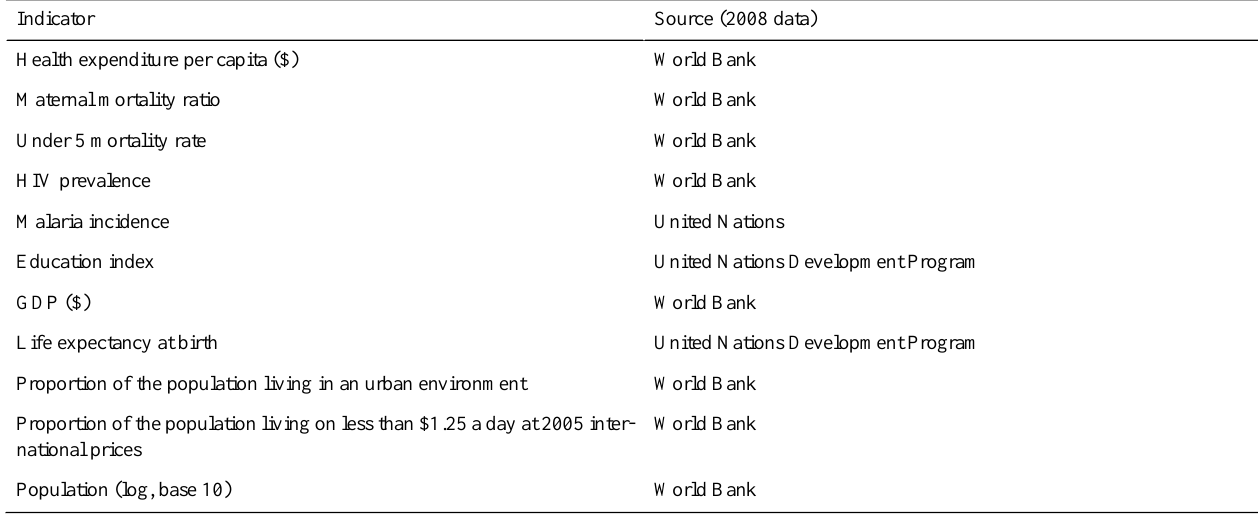
Table 2. Country indicators used for context